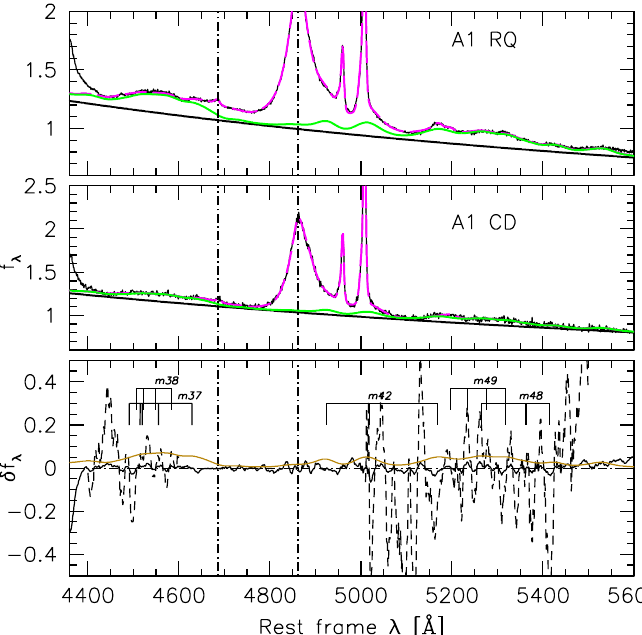
Figure 3. From top to bottom: Non-linear χ 2 multi-component analysis with a solid Fe II template of RQ, CD, and of the residuals in Fe II emission for composites of spectral type A1. In the bottom panel the brown line traces the difference in the template (positive, since Fe II is stronger in RQ than in CD). The black filled lines traces the difference between the observed Fe II emission after rescaling of the CD Fe II to obtain a minimum average ∼ 0. The dashed line traces the relative difference, i.e., (Fe II RQ − Fe II CD)/Fe II RQ. Wavelengths of multiplet lines are from Moore